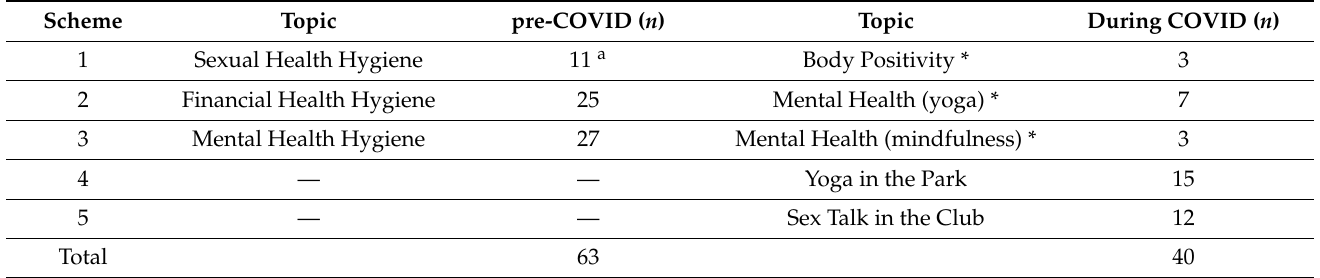
Table A1. Comparison of attendance for Whole YOUniversity 1.0 (pre-COVID) vs. 2.0 (during COVID).